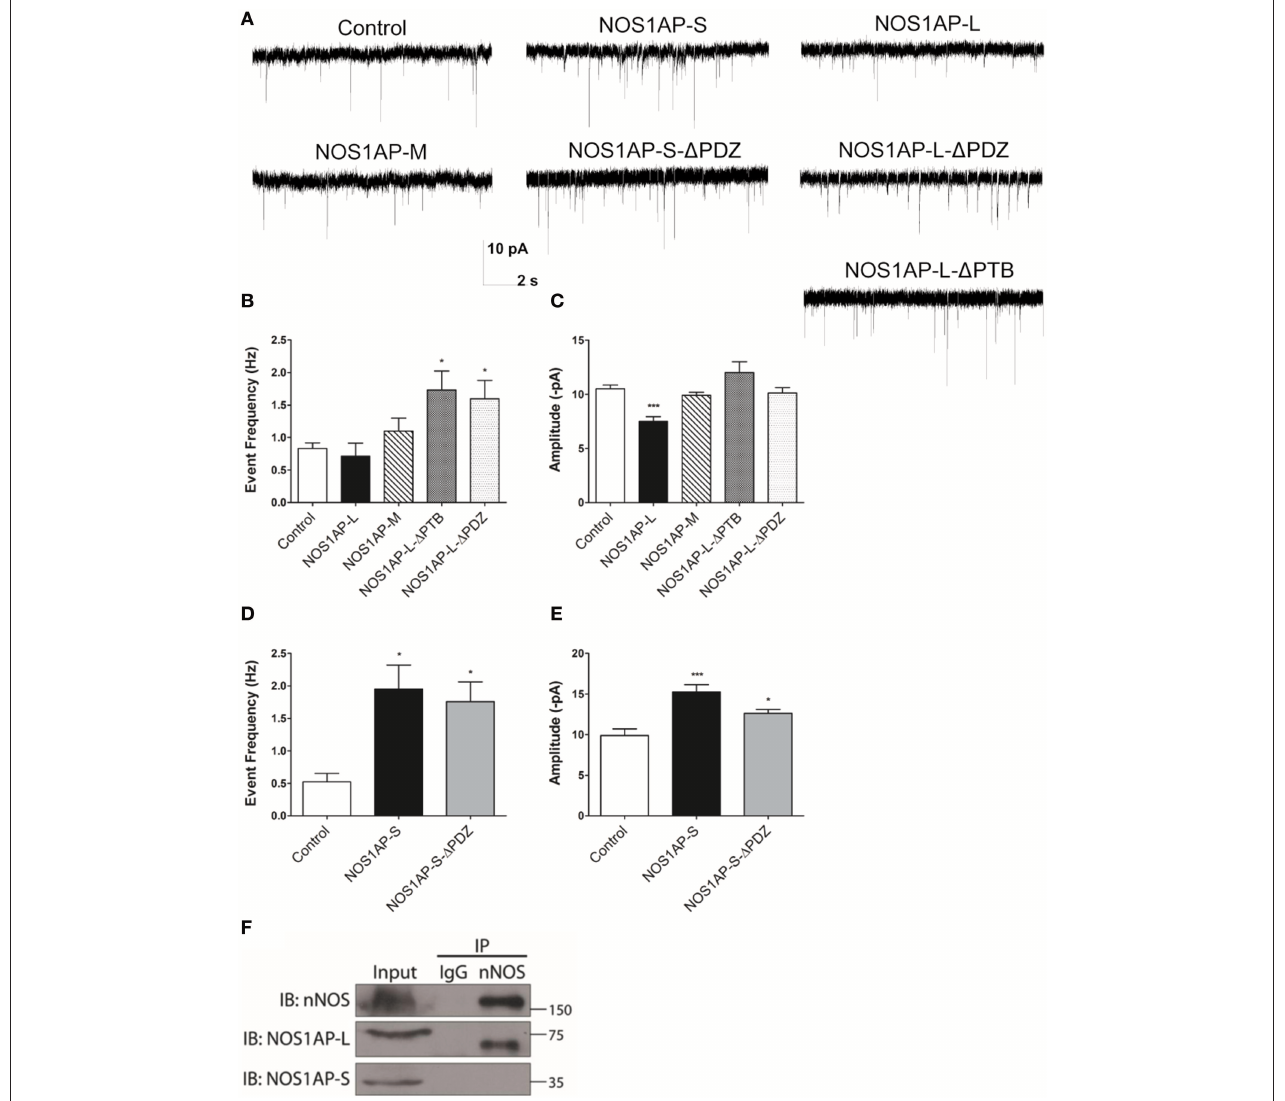
FIGURE 7 | NOS1AP-S increases synaptic strength, while NOS1AP-L decreases synaptic strength. (A) Representative tracings of miniature excitatory postsynaptic currents (mEPSCs) from rat cortical neurons (DIV 17) transfected with pCAG-GFP (control), pCAG-GFP-NOS1AP-L, pCAG-GFP-NOS1AP-S, pCAG-GFP-NOS1AP-S- 1 PDZ, pCAG-GFP-NOS1AP-M, pCAG-GFP-NOS1AP-L- 1 PTB, or pCAG-GFP-NOS1AP- 1 PDZ. (B) Average frequency of mEPSCs in cultured neurons expressing indicated proteins. (C) Average amplitude of mEPSCs in cultured neurons expressing indicated proteins. Error bars indicate s.e.m. n = 62 cells, Control; n = 14, NOS1AP-L; n = 15, NOS1AP-M; n = 15, NOS1AP-L- 1 PTB; n = 22, NOS1AP-L- 1 PDZ. * p < 0.05; *** p < 0.001 vs. Control. p -values were determined by one-way ANOVA followed by Bonferroni Multiple Comparisons test. Error bars indicate ± s.e.m. (D) Average frequency of mEPSCs in cultured neurons expressing indicated proteins. (E) Average amplitude of mEPSCs in cultured neurons expressing indicated proteins. Error bars indicate s.e.m. n = 11 cells, Control; n = 18, NOS1AP-S; n = 19, NOS1AP-S- 1 PDZ. * p < 0.05; *** p < 0.001 vs. Control. p -values were determined by one-way ANOVA followed by Bonferroni Multiple Comparisons test. Error bars indicate ± s.e.m. (F) Immunoprecipitated proteins from rat brain by anti-nNOS or IgG were resolved by SDS-PAGE. Western blots were probed for nNOS and NOS1AP isoforms. A representative Western blot of three individual experiments is